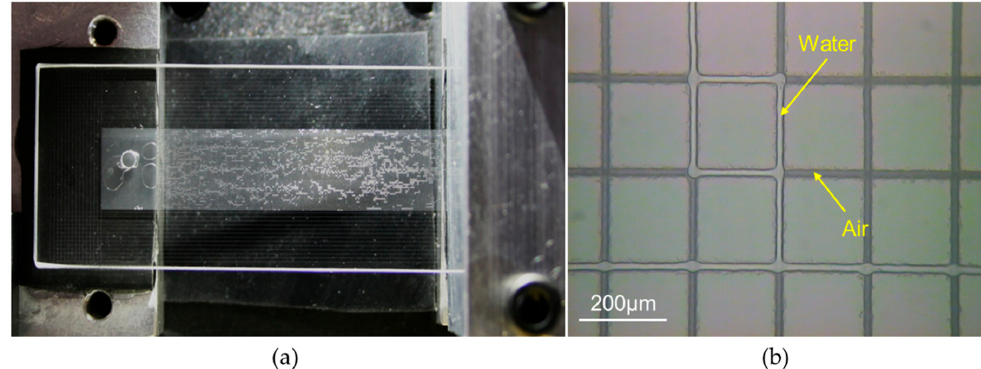
Figure 10. ( a ) Photograph taken during the testing of a laser-manufactured microfluidic device; ( b ) zoomed image of the microstructure partially filled in with water. This image was obtained using a Leica optical microscope.